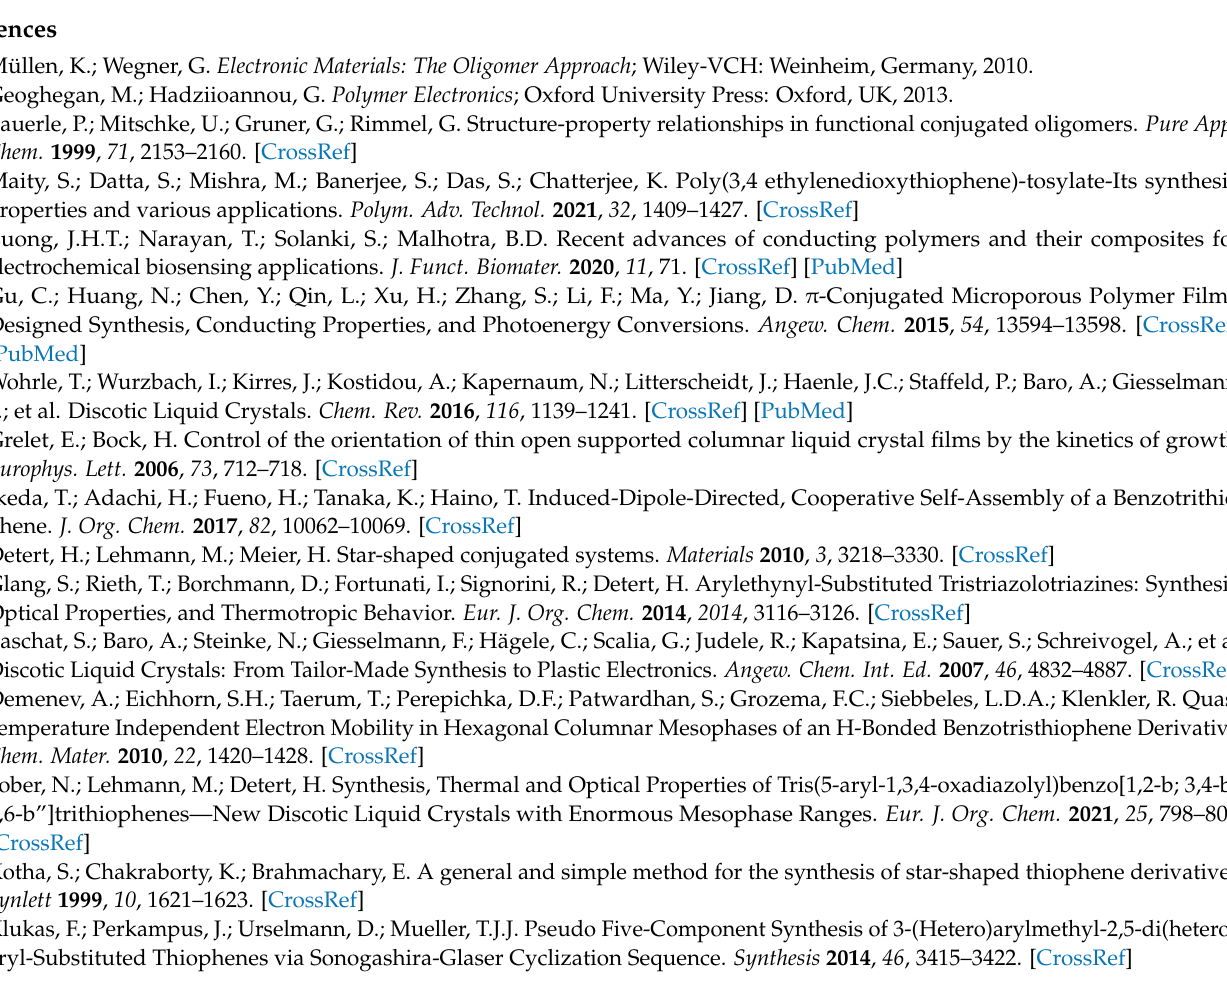
NMR-spectrum, Figure S3: 13C-NMR spectrum, Figure S4: 1H-1H-COSY NMR spectrum, Figure S5: HMBC NMR spectrum, Figure S6: HSQC NMR spectrum, Figure S7: DSC, Figure S8: